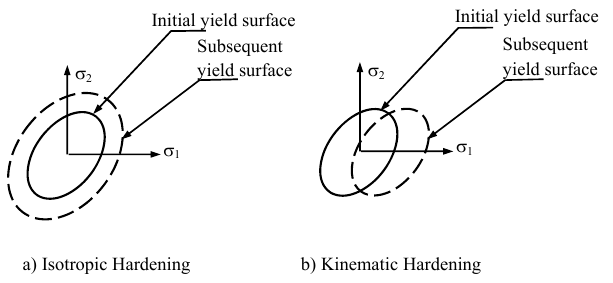
Fig. 2. Isotropic and kinematic hardening rules.